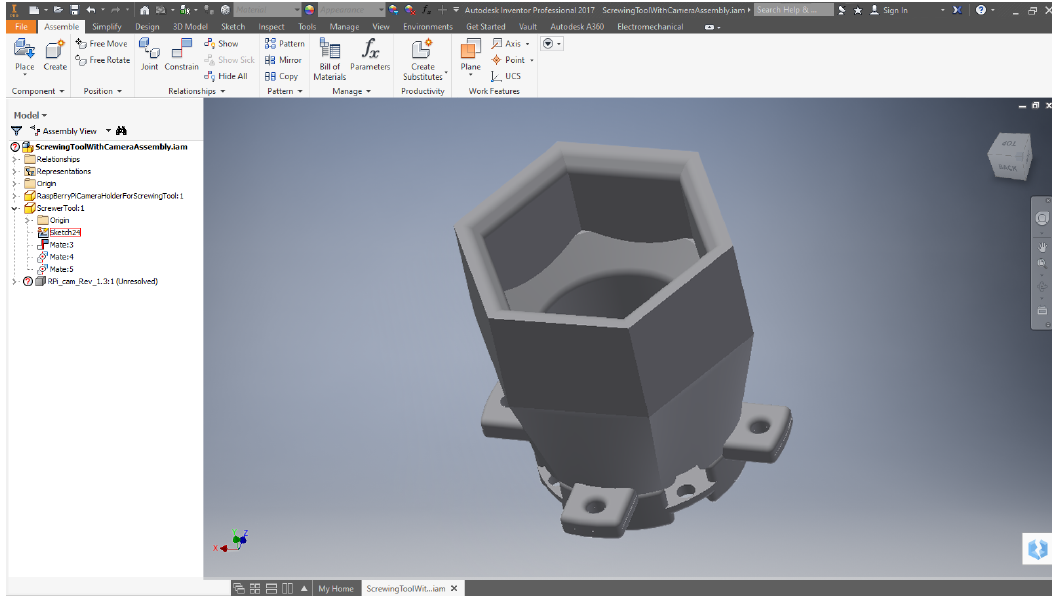
Figure 10. Example of tool designed by advanced students using Autodesk Inventor.